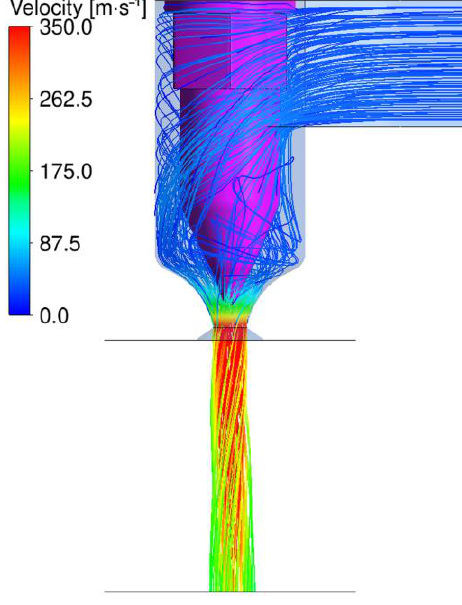
Figure 9. Simulation of air flow: streamlines for the center nozzles. The downward spiral is one of the main differences compared to meltblown processes and was therefore a focus of the CFD analysis. The comparison did show a significantly higher vorticity for the Nanoval process, with less applied air throughput for the first few millimeters after the polymer exits the nozzle. A visual representation of the comparison is shown in Figure 10, where the left graphic (Figure 10a) is the Nanoval process with the same boundary conditions as in the previous figure (Figure 9), and on the right side (Figure 10b) is a meltblown process with an air pressure of 1 bar (corresponding to 325 Nm 3. h − 1 throughput) and a temperature of 412 ◦ C. In both graphics, a plane through the center of one capillary is colored by the vorticity.